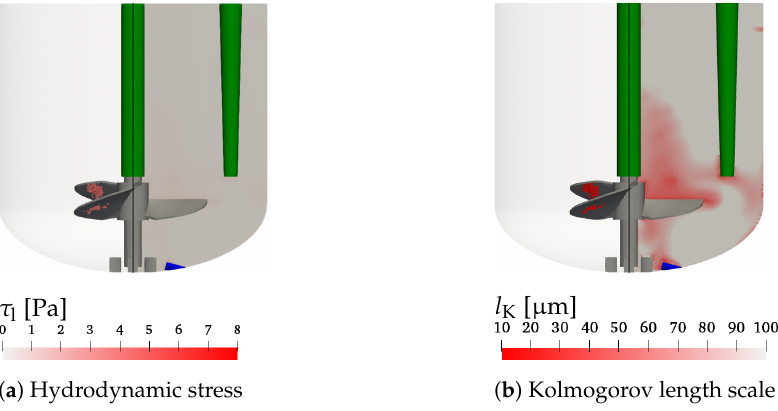
Figure 7. Hydrodynamic stress ( a ) and Kolmogorov length scale ( b ) for V = 1.7 L, n = 150 rpm, and Q = 50 mL min − 1 (condition #7). Left parts: control volumes with τ l > 3.14 Pa and l K < 20 µ m, respectively. Right parts: values on the x - z plane through the center of the